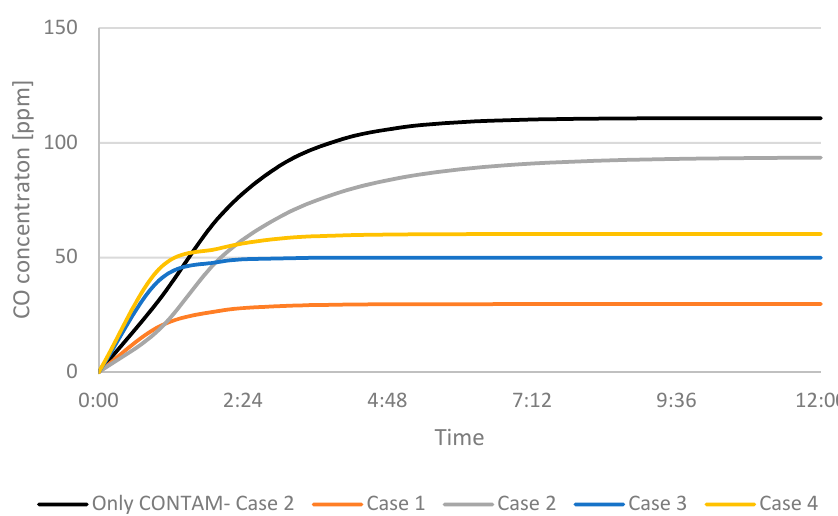
Figure 6. CO concentration in the garage.